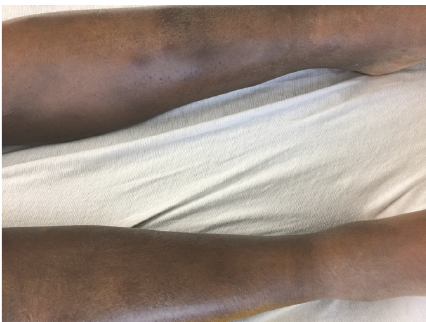
Figure 1: Erythema nodosum on pretibial surface of lower extrem- ity.